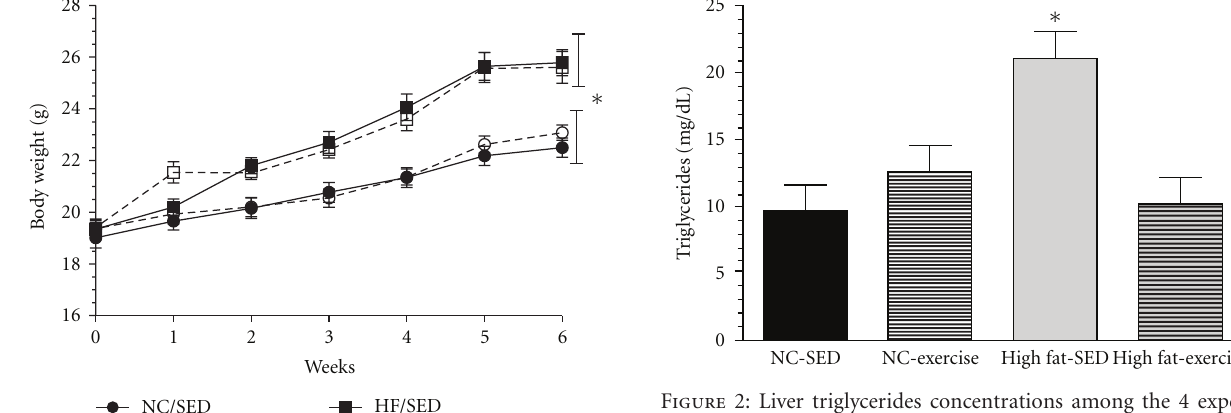
Figure 2: Liver triglycerides concentrations among the 4 experi- mental groups. High fat/sedentary (HF/SED) had the greatest tri- glyceride content compared to the 3 remaining groups ( ∗ P < 0 . 0001) (low fat/SED, LF/exercise (LF/EX), and HF/EX), with no di ff erences among these three